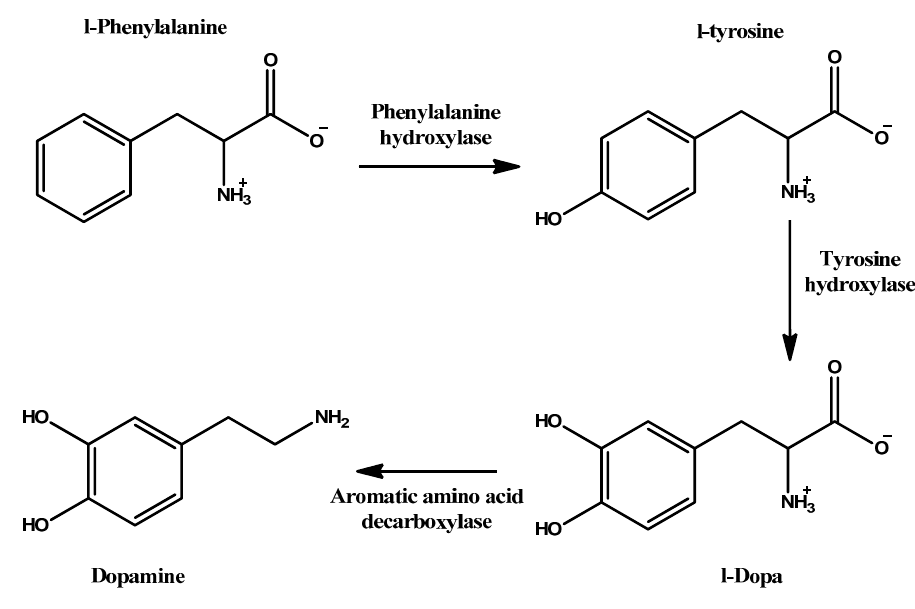
Scheme 1. Dopamine synthesis pathway.